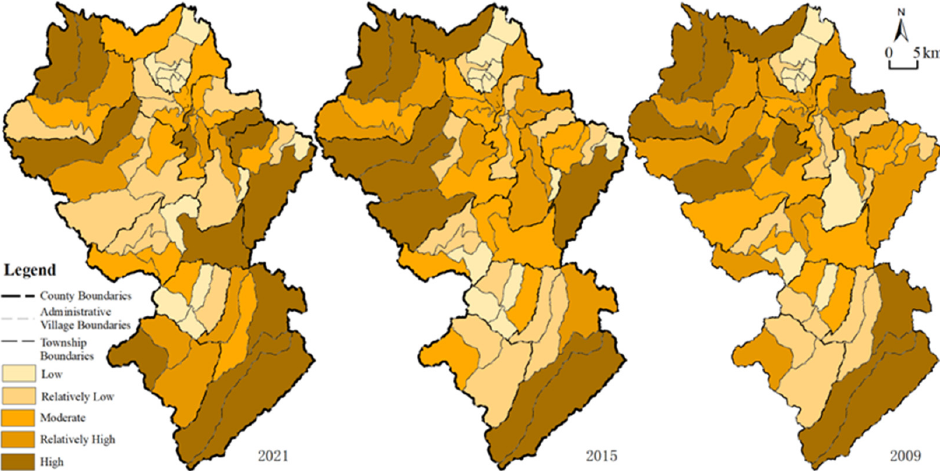
Figure 4. Spatial distribution of level of land use for rural tourism facilities in 2021, 2015, and 2009.